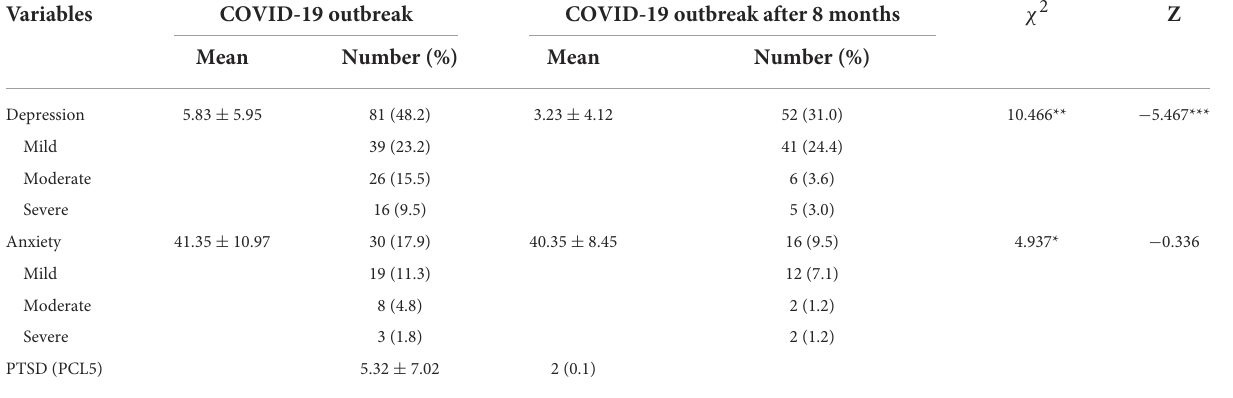
TABLE 2 Depression, anxiety, and PTSD in study participants.